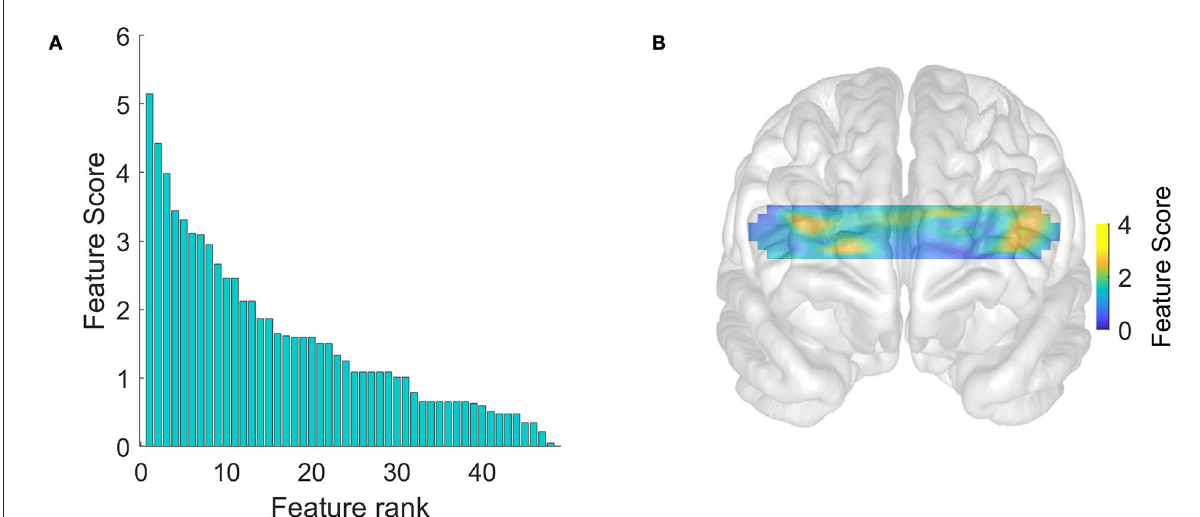
FIGURE2 Hemodynamic feature priority scores calculated for purposes of feature selection. (A) Univariate feature priority scores ranked in descending order calculated using chi-squared tests. (B) The distribution of scores over the prefrontal